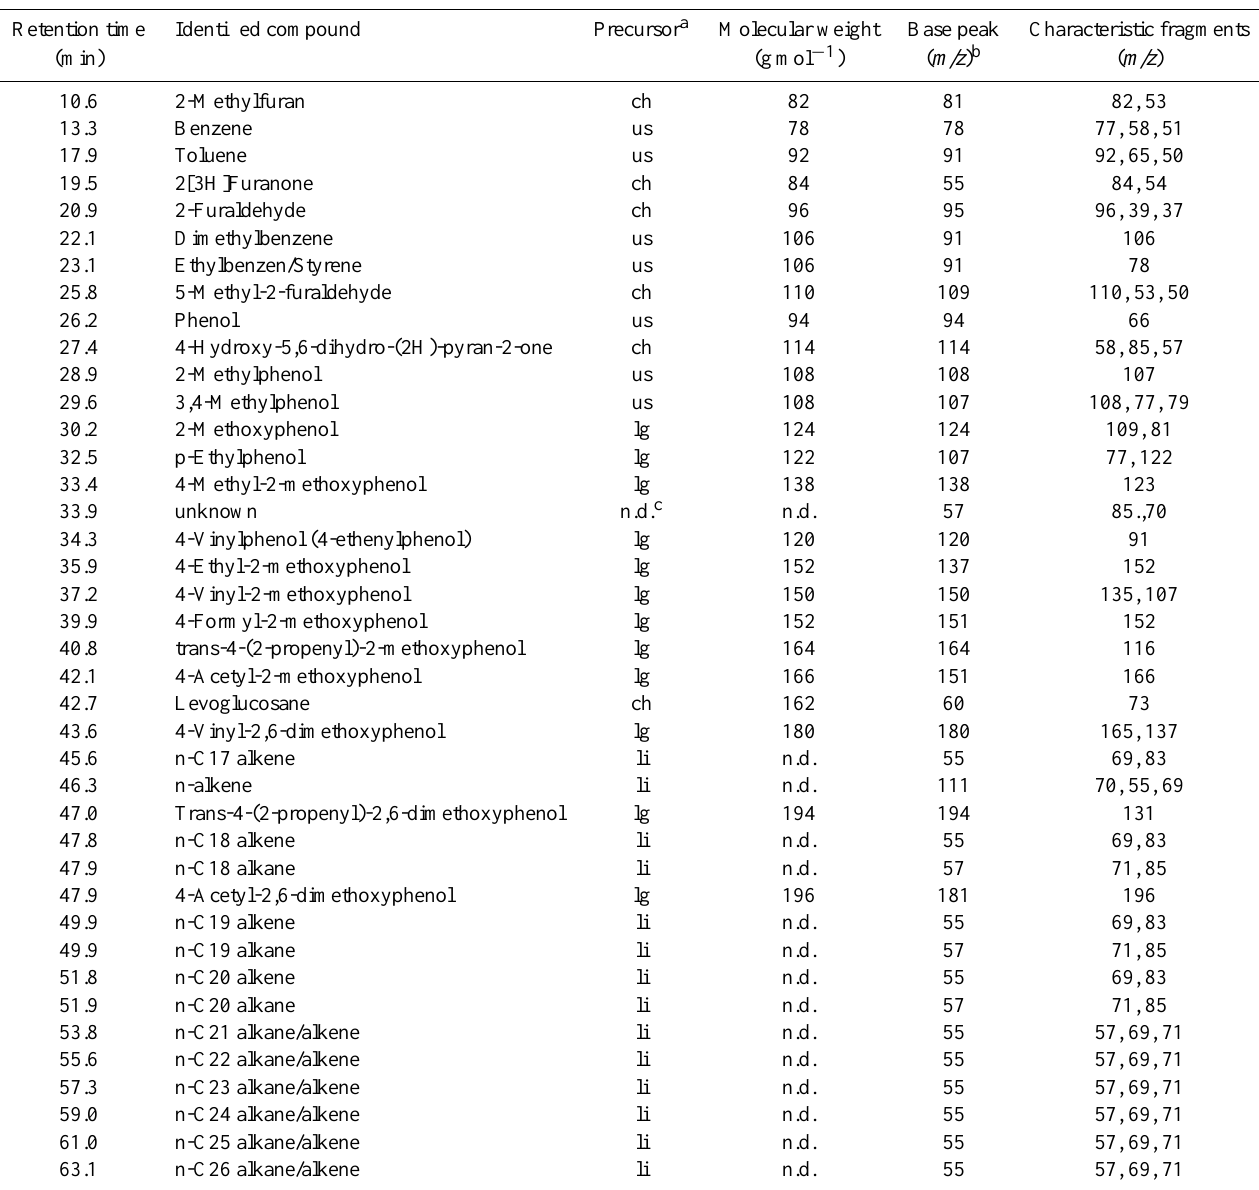
Table 1. Retention time, peak identification, precursor groups, and mass spectrometric characteristics of major pyrolysis products present in selected peat samples (C2, D2, M, according to Fig. 4) obtained over depth (0–40cm) of an acidic